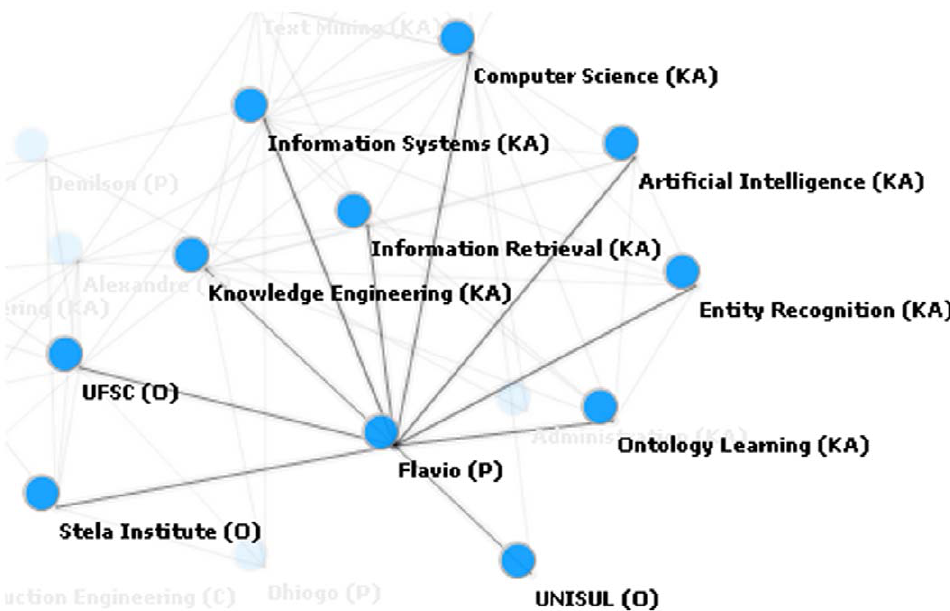
Figure 4. Relations among ‘‘flavio’’ (class person) and other instances.